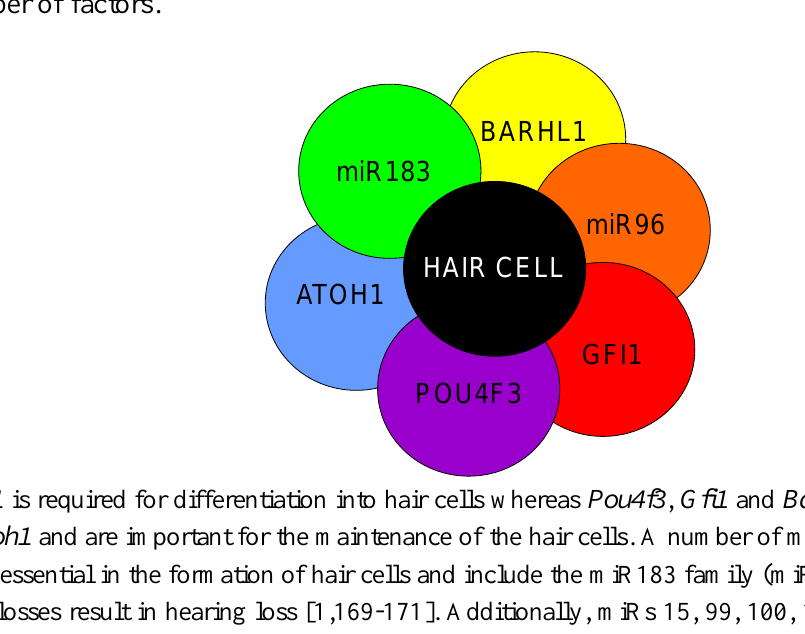
Figure 5. Differentiation of a sensory progenitor cell to a hair cell is dependent on a number of